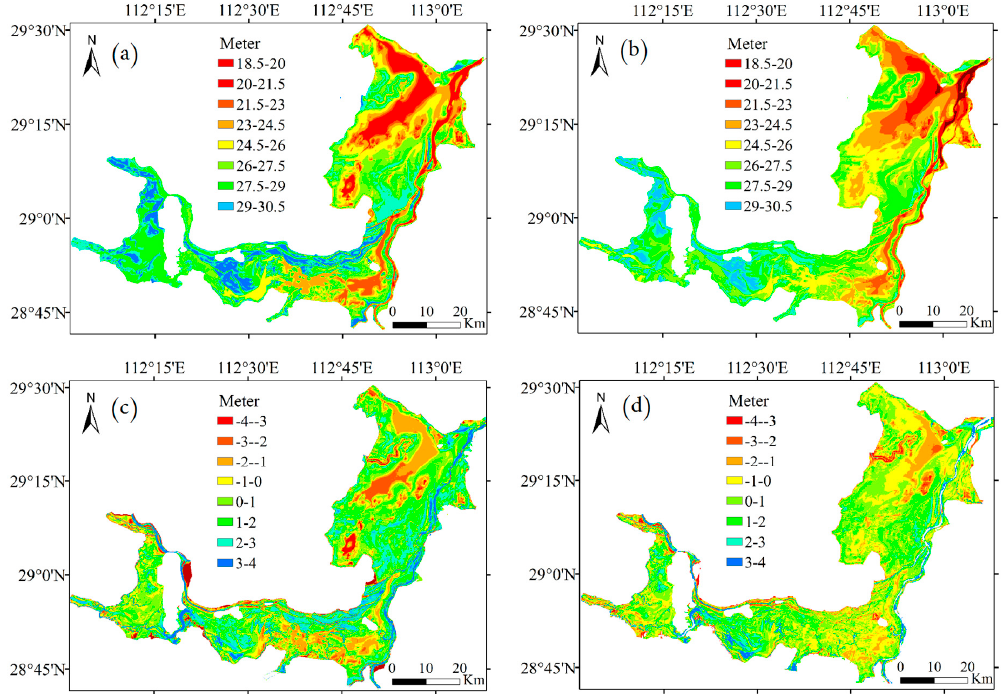
Figure 13. Lake bathymetry model in the Dongting Lake area: ( a ) Feng model; ( b ) kriging model; ( c ) distribution of the difference in the water level between the Feng and measured elevation grid models; ( d ) distribution of the difference in the water level between the kriging and measured elevation grid models.